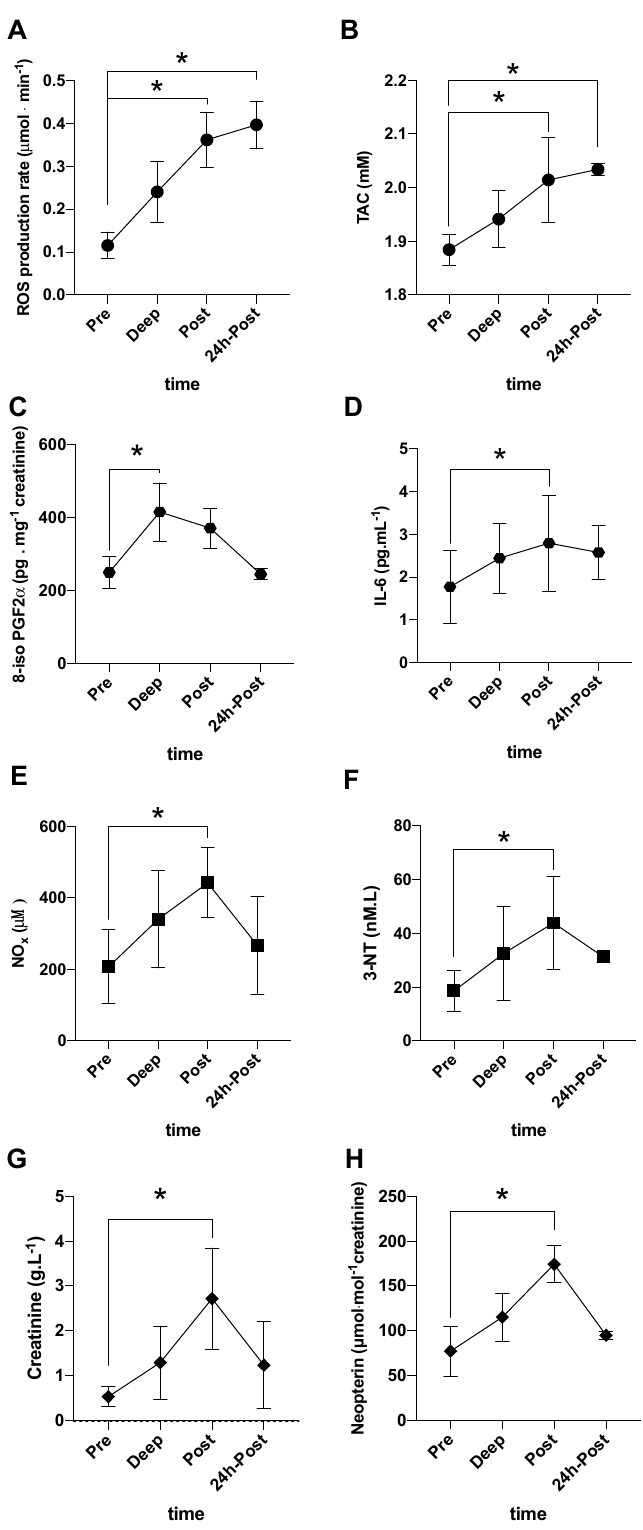
Figure 2. Biomarkers kinetic during saturation diving. Time course of: ( A ) ROS production rate ( µ mol · min − 1 ) and ( B ) antioxidant capacity (TAC − mM) in saliva calculated by electron paramagnetic resonance (EPR); ( C ) 8-isoprostane (8-iso-PGF2 α -pg · mg − 1 creatinine); ( D ) Interleukin-6 (IL-6, pg · mL − 1 ); ( E ) nitric oxide metabolites (NOx, µ M), and ( F ) 3-Nitrotyrosine (3-NT, nM · L − 1 ); ( G ) creatinine (g · L − 1 ); ( H ) neopterin ( µ mol.mol − 1 creatinine), concentrations detected in urine. All samples were collected at pre-, at deep, post-, and 24 h post-dive in saturation divers. * p < 0.05.